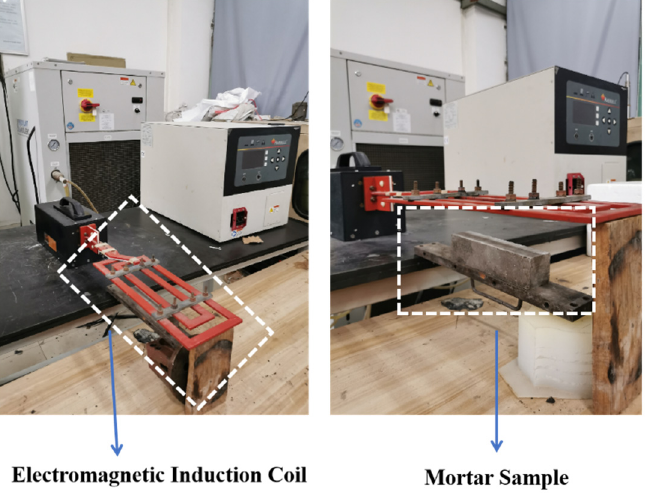
Figure 2. Electromagnetic induction heating